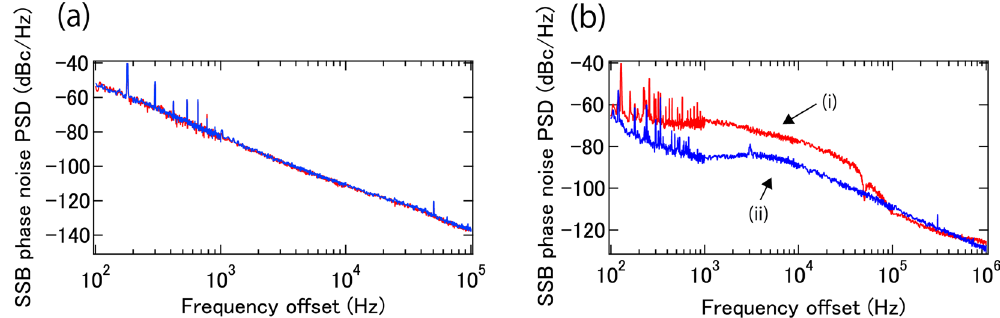
WILTRON, 6747A (i, red) and Hewlett-Packard, 8341A (ii,